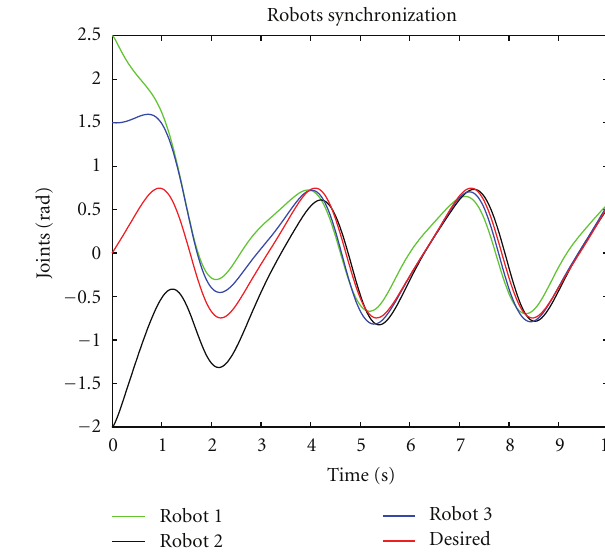
Figure 8: Robots synchronization in presence of time delay (0.5s).